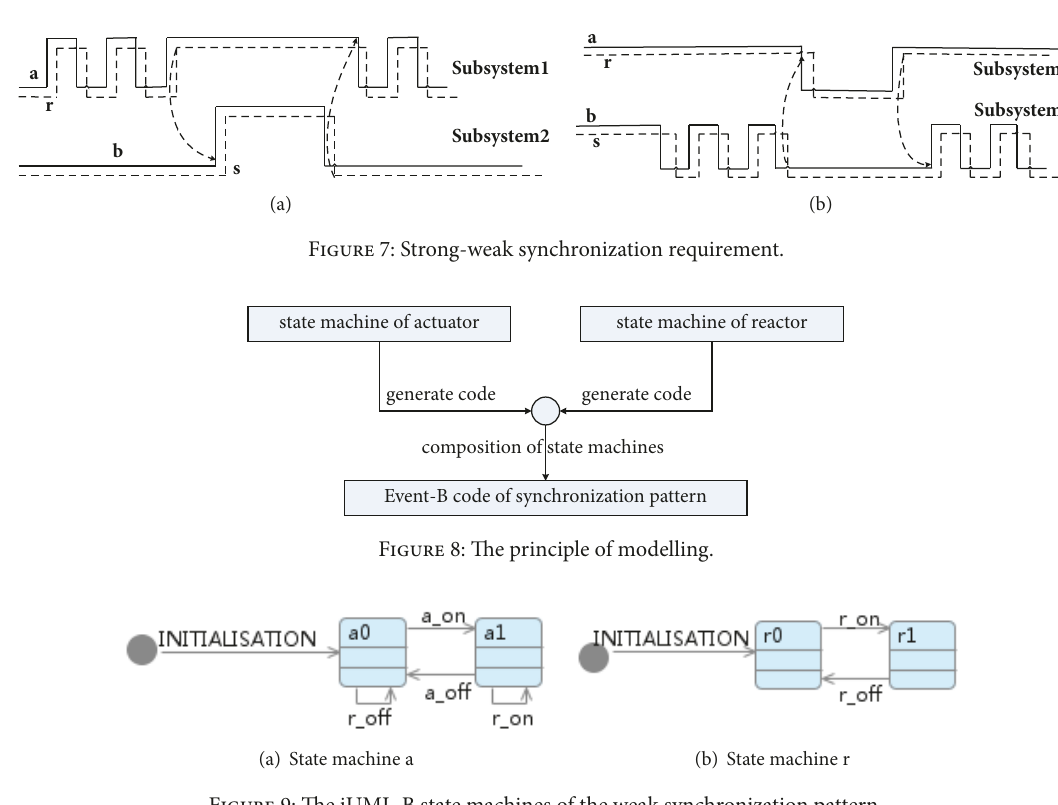
Figure 9: The iUML-B state machines of the weak synchronization